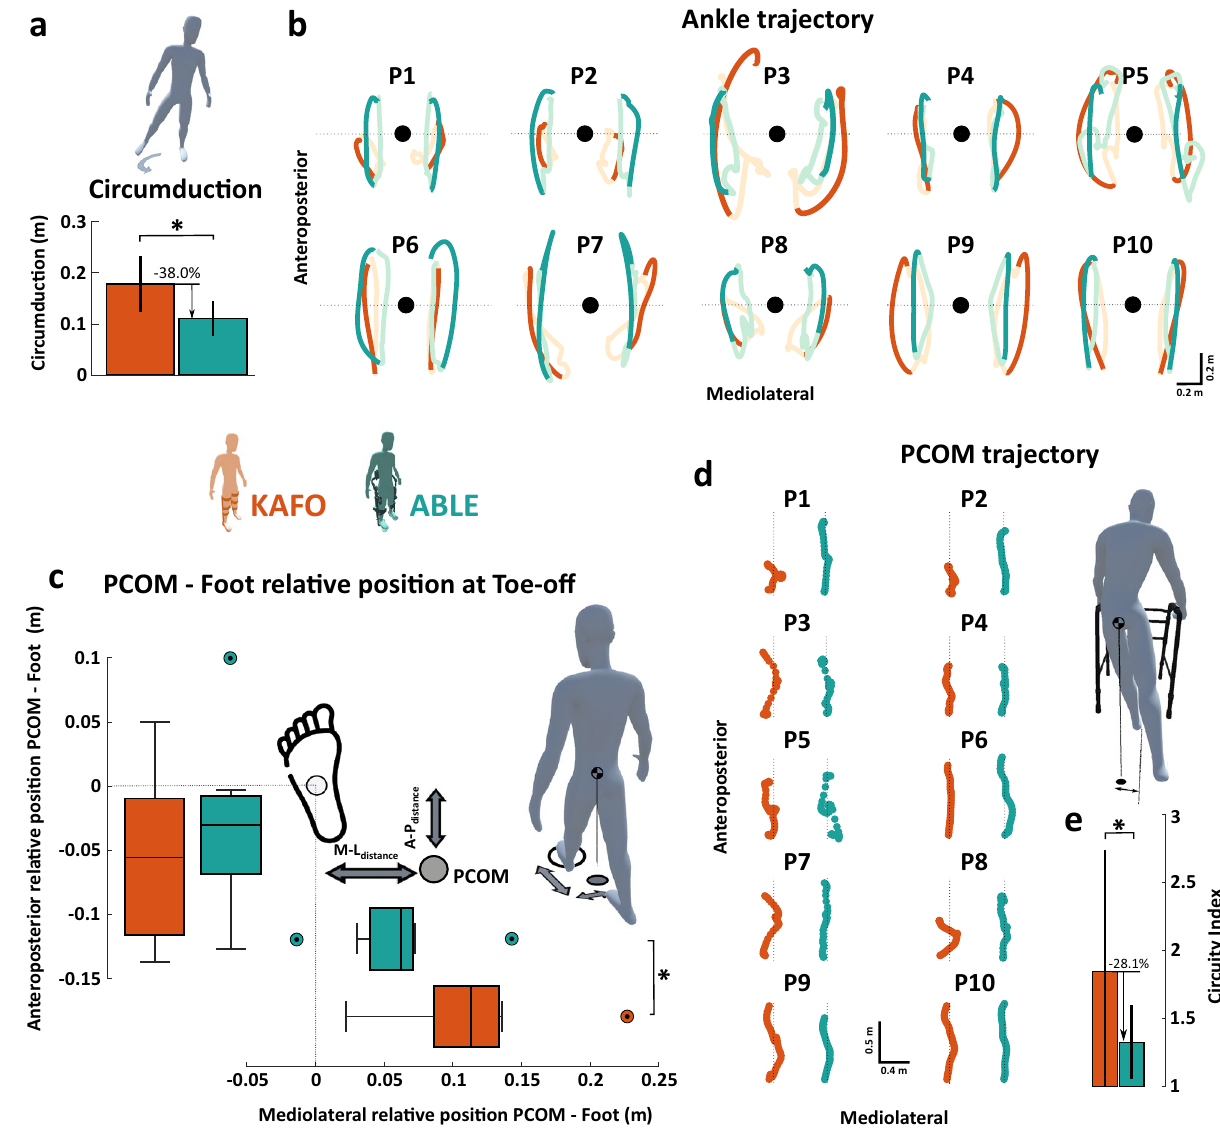
Figure 4. ( a ) Circumduction during the 6 MWT. Circumduction was defined as the maximum lateral difference of the ankle marker between stance and swing phase. Bars show the mean and standard deviation from all the participants. ( b ) The average ankle marker trajectory with respect to the PCOM in the transverse plane during the gait cycle for each participant. Black circles represent the PCOM, measured as the middle point between trochanters. ( c ) Box plot of the relative position of the PCOM with respect to the center of the leading foot at toe-off in both anteroposterior and mediolateral directions. Statistical analysis was done using the mean values using each device. ( d ) Trajectories of the PCOM (big circle) in the transverse plane during an average gait cycle for each participant. Dashed lines show the straight path to follow while walking. ( e ) Circuity index mean and standard deviation using each device. The circuity index is defined as the ratio of the total distance covered by the PCOM trajectory to the euclidean distance between its first and last position in the transverse plane during a gait cycle. Data were recorded during the 6 MWT. Stars (*) indicate statistically significant differences ( p < 0.05